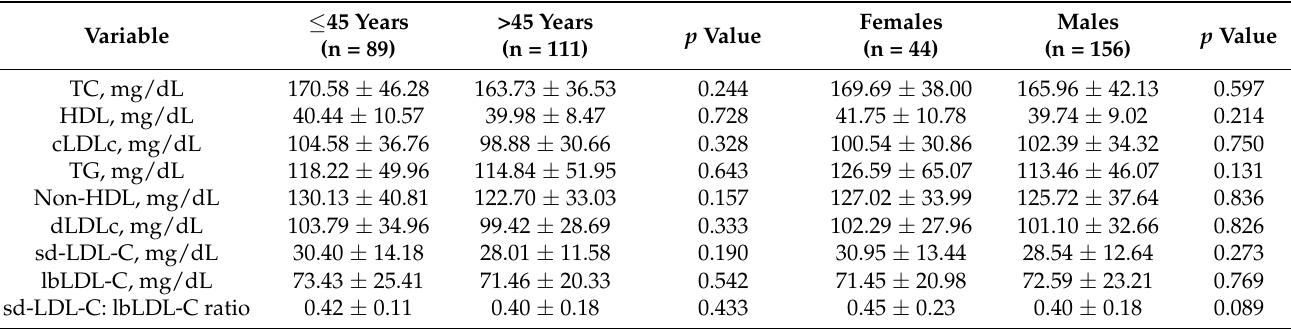
Table 3. Lipid profile according to patient age and gender.